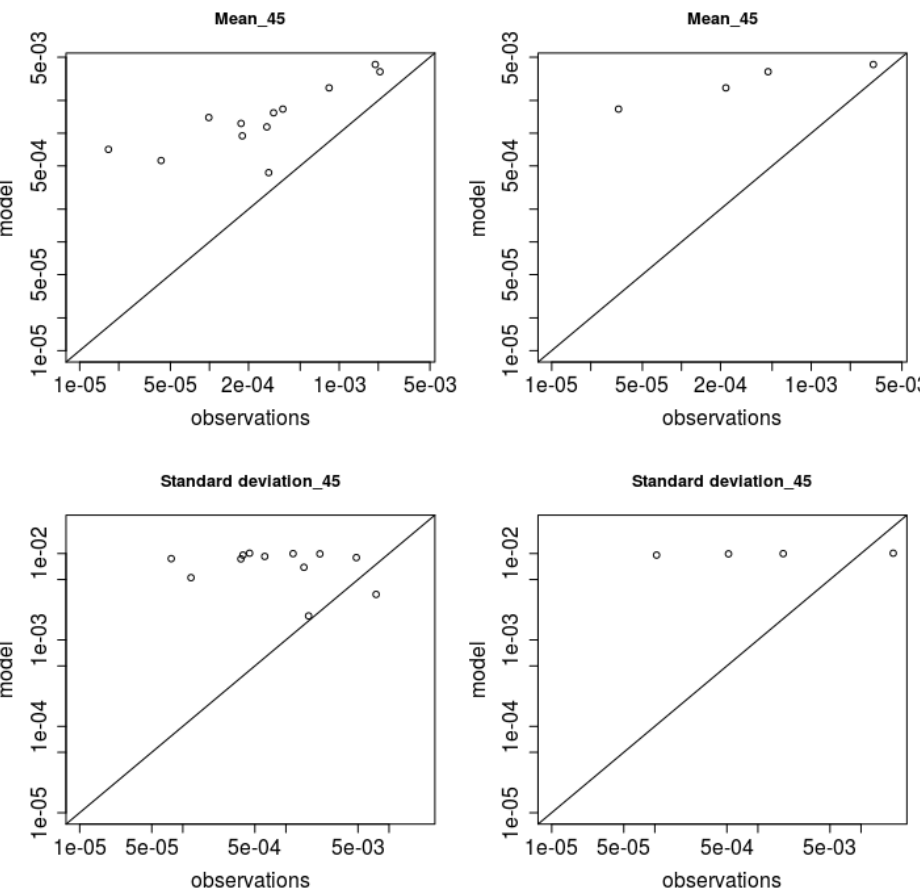
Figure 5. Scatter-plot ( left ) and qq-plot ( right ) for trial 45 (unstable conditions) ( g / m − 3